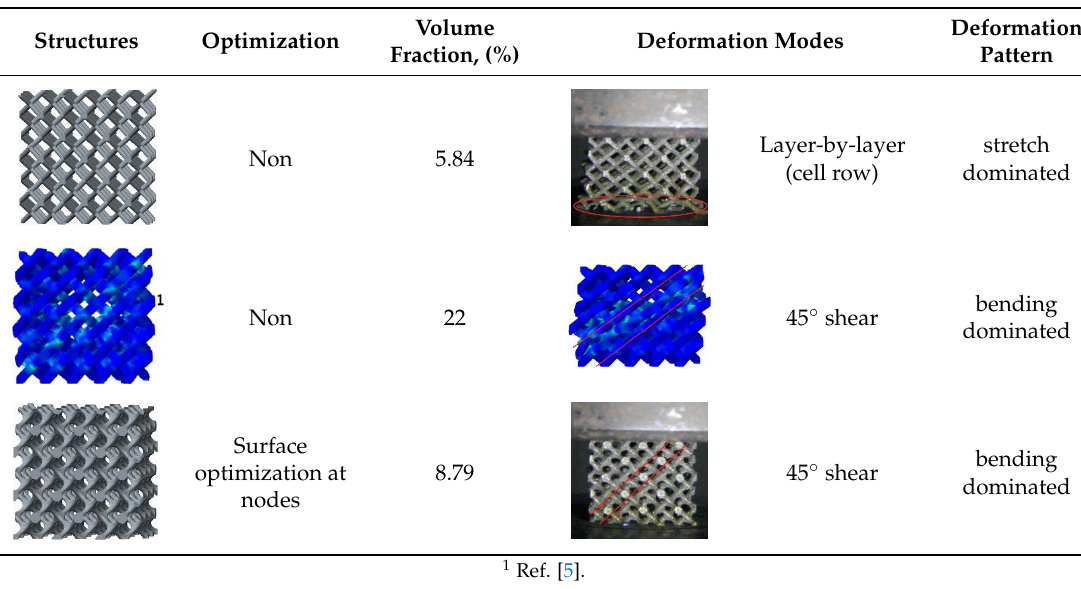
Figure 10. SEM morphologies of fracture surface: ( a – c ) tensile yield at node with ductile dimpling for sample 0600, ( d – g ) shear rupture at rod for sample 0616.